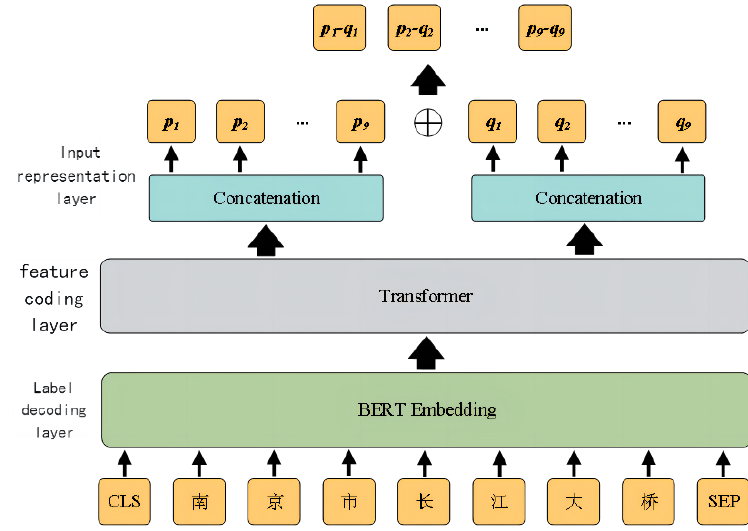
Figure 1. Multi-task learning network model.